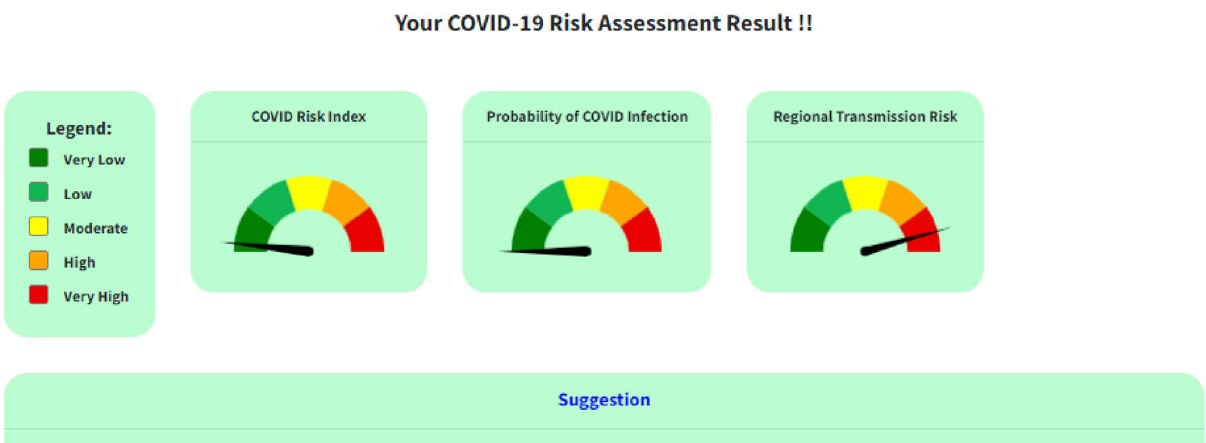
Figure 6. Result of COVIRA tool on-screen after personal risk